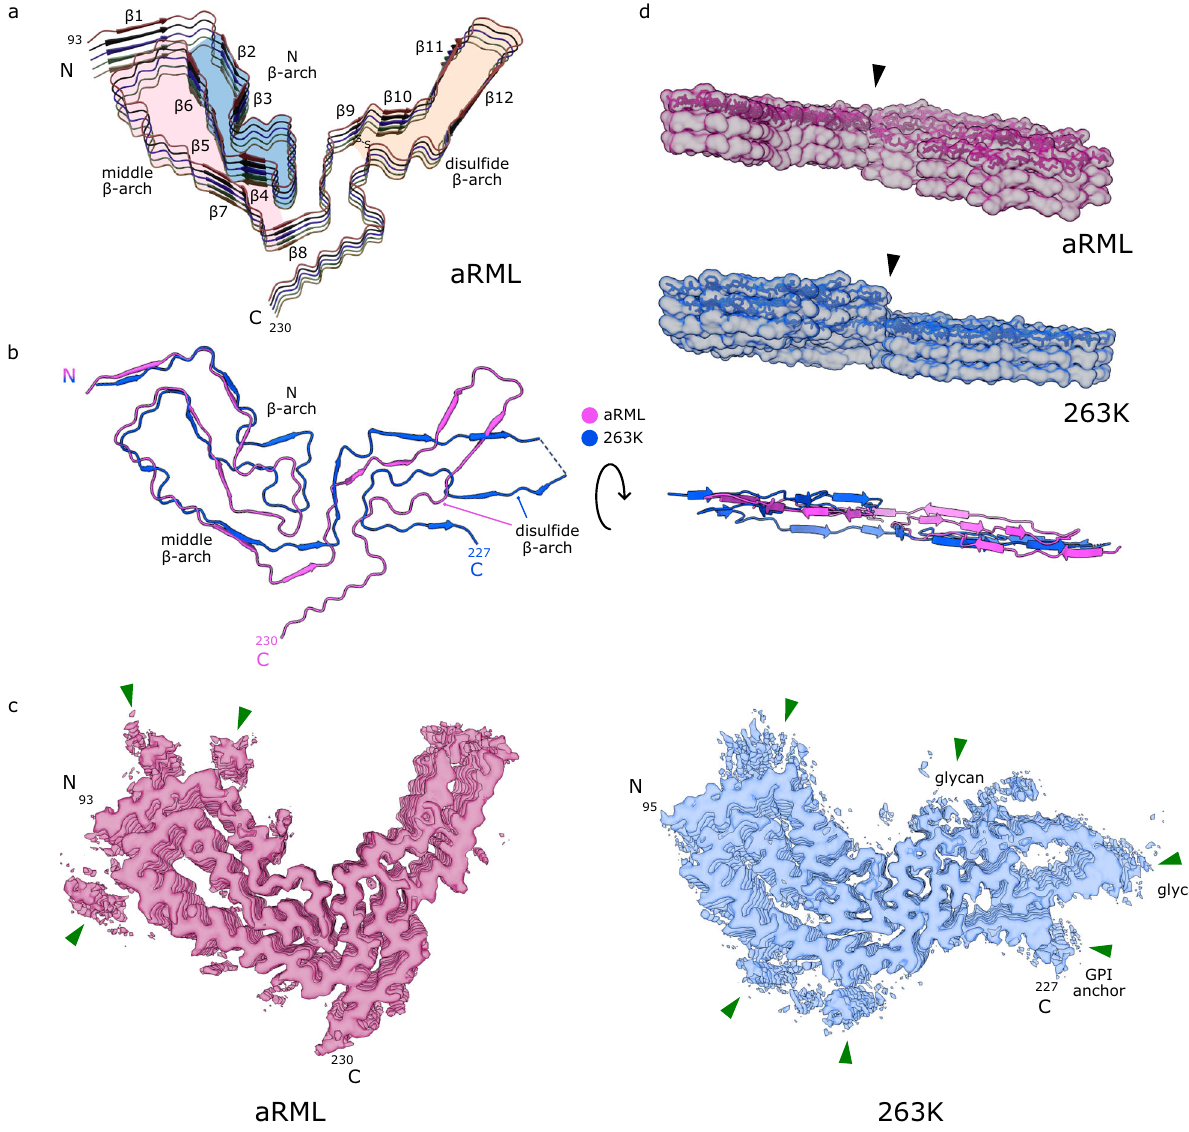
Fig. 2 Comparison of aRML and 263K prions. a Ribbon diagram of aRML core (stack of 5), with structural motifs as colored. b Overlay of aRML and 263K cores. c Contour EM density maps of aRML and 263K. Green arrows indicate peripheral unassigned densities associated with cationic residues in the N-terminal lobes of both strains, but absent in the aRML C-terminal lobe, consistent with aRML ’ s lack of glycans and glycolipid anchors. d Lateral views of aRML and 263K EM maps (stacks of 3) with stick models embedded in top rung. Arrowhead indicates protrusion of anvil-like head of the N β -arch. Underneath is a ribbon overlay of aRML and 263K monomers indicating differences in